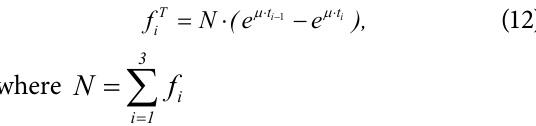
Table 8. Theoretical frequencies